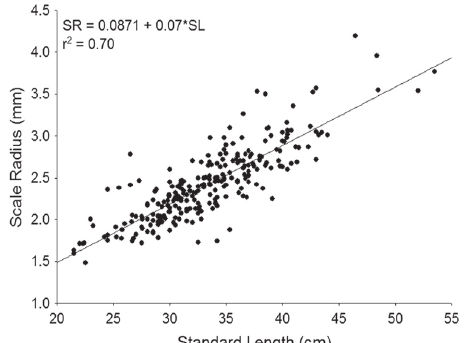
Fig. 3. Relationship between standard length (cm) and total scale radius (mm) of Cichla temensis from the middle rio Negro. SL = standard length; SR = scale